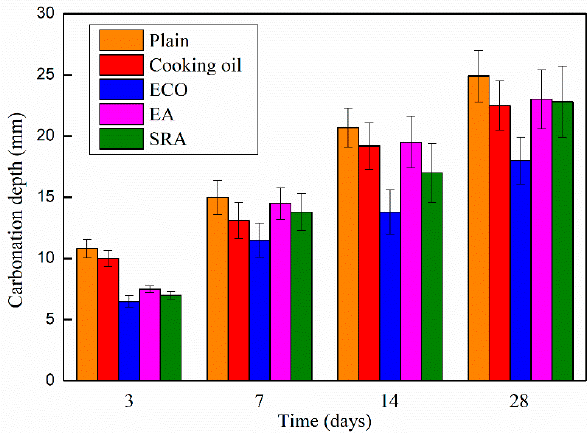
Figure 7. Carbonation depth of AASC with various of agents.